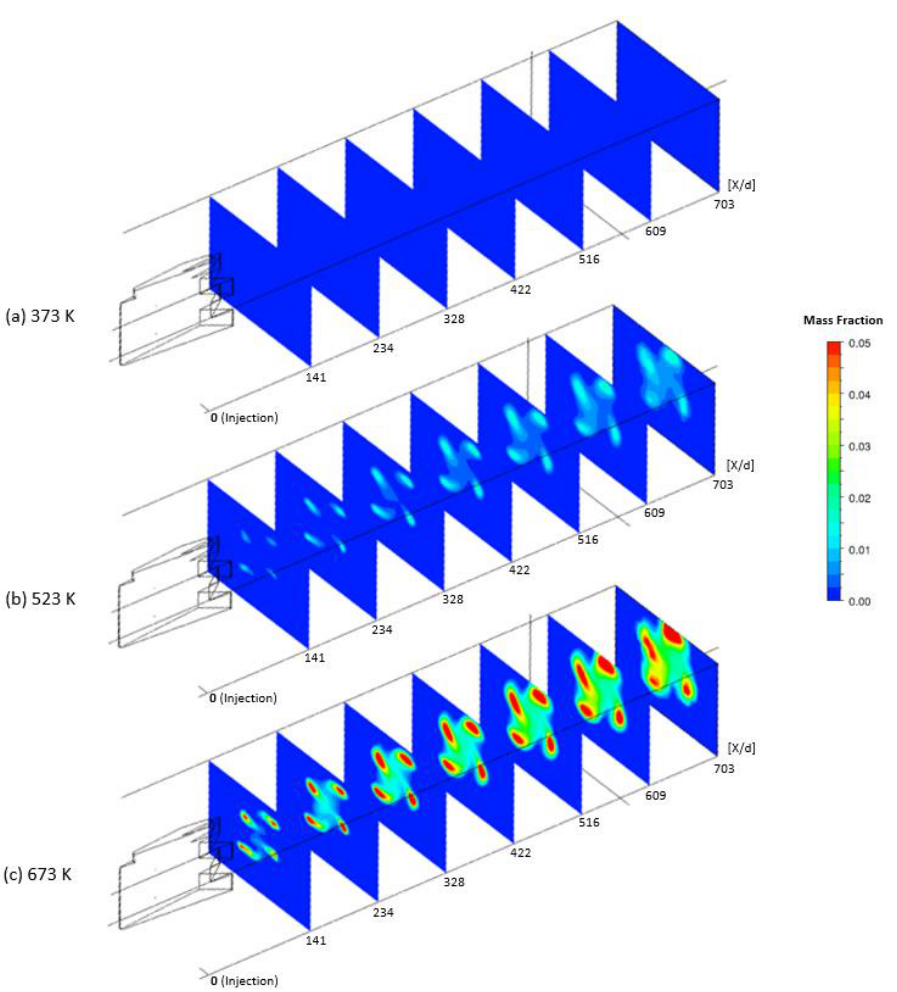
Figure 9. Vaporized fuel mass fraction contours at various locations downstream of the pylon for three different air temperatures. Figure 10 shows the comparison of the mixing efficiencies downstream of the pylon for three different air temperatures. When the temperature was 373 K, the mixing effi- ciency was zero because there was no vaporized fuel as shown in Figure 9a. However, as the air temperature increased, the mixing efficiency increased linearly downstream of the pylon. At an air temperature of 523 K, the mixing efficiency was 10% at the combustor outlet (X/d = 703), and at a higher air temperature of 673 K, the mixing efficiency reached 51% at the combustor outlet. Therefore, it can be confirmed that the air temperature has a significant effect on the mixing efficiency.